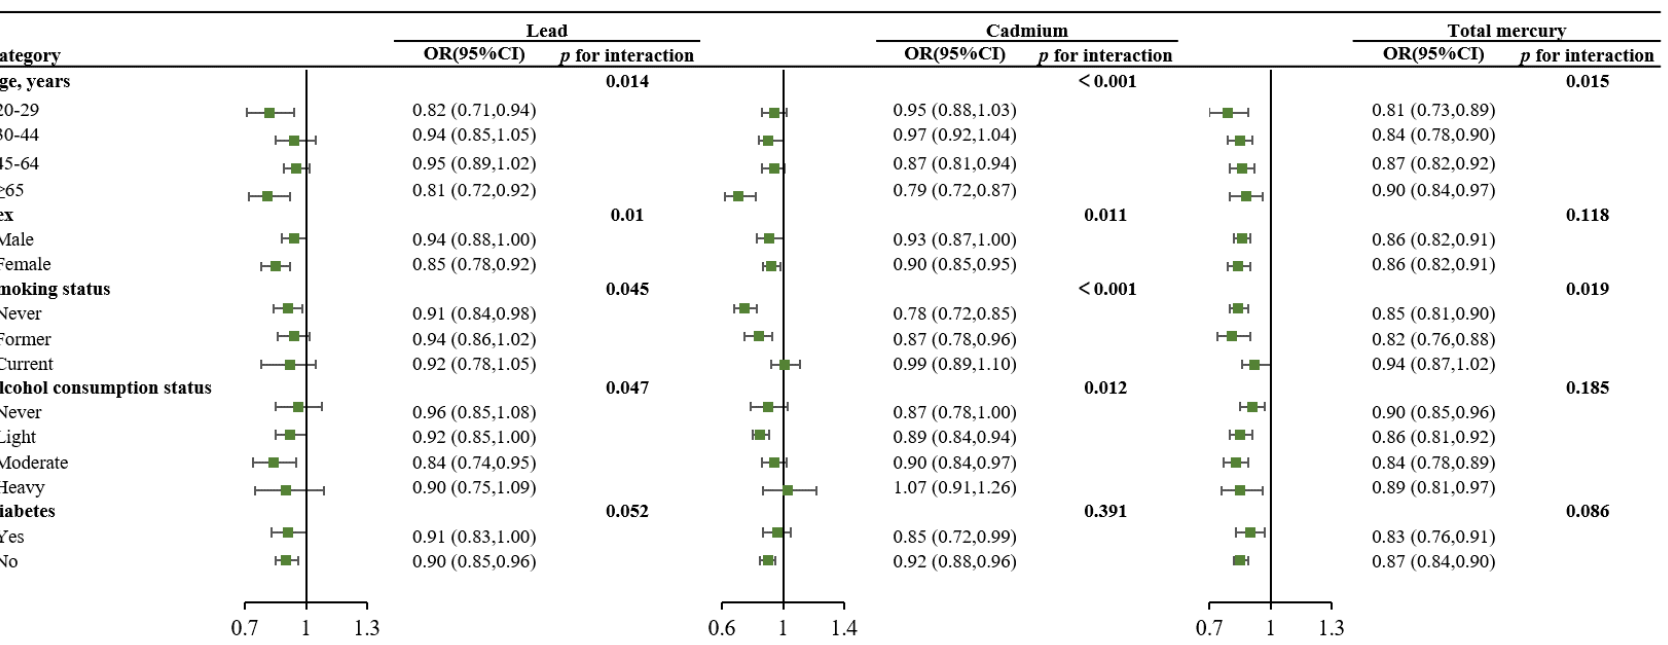
Figure 4. Subgroup analyses for the associations of heavy metals (per interquartile range increment) with risk of obesity. Upper figure: Subgroup analyses for heavy metals and risk of peripheral obesity. Lower figure: Subgroup analyses for heavy metals and risk of abdominal obesity. NHANES, National Health and Nutrition Examination Survey; BMI, body mass index; WC, waist circumference; HEI, The Healthy Eating Index. All results were adjusted for age, sex, race, education level, marital status, income, smoking, alcohol consumption, physical activity, diabetes, and cardiovascular disease, except for stratified variables sep- arately.